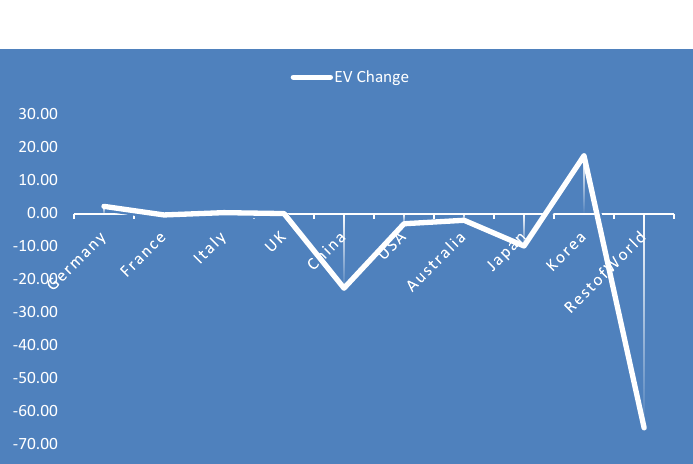
Fig. 2: Changes in welfare (in USD billion dollars)